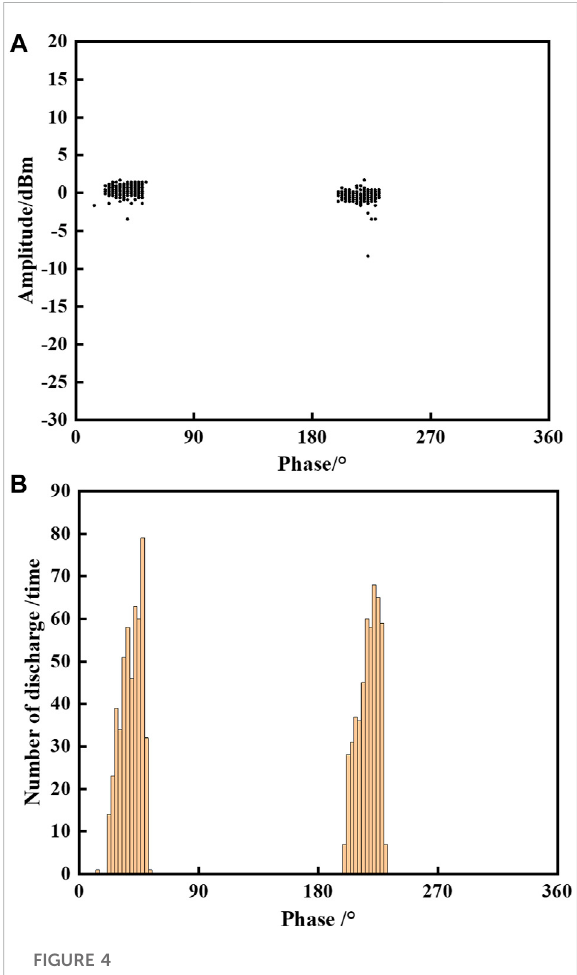
FIGURE 4 UHF signals of suspension discharge at 36.17 kV. (A) PRPD pattern. (B) φ −